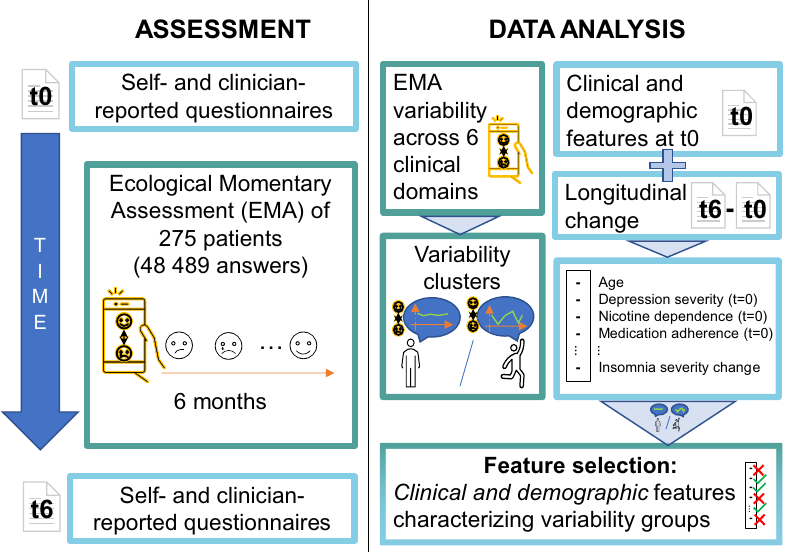
Figure 1. Overview of the study. Notice that the main aim of this paper is to find and analyze which clinical and demographic features could be associated with each variability profile. The candidate set of clinical and demographic features (whose possible association to the variability profiles was analyzed) was obtained upon inclusion and at the end of the follow-up. Hence, some longitudinal features were considered by computing the change at those discrete time